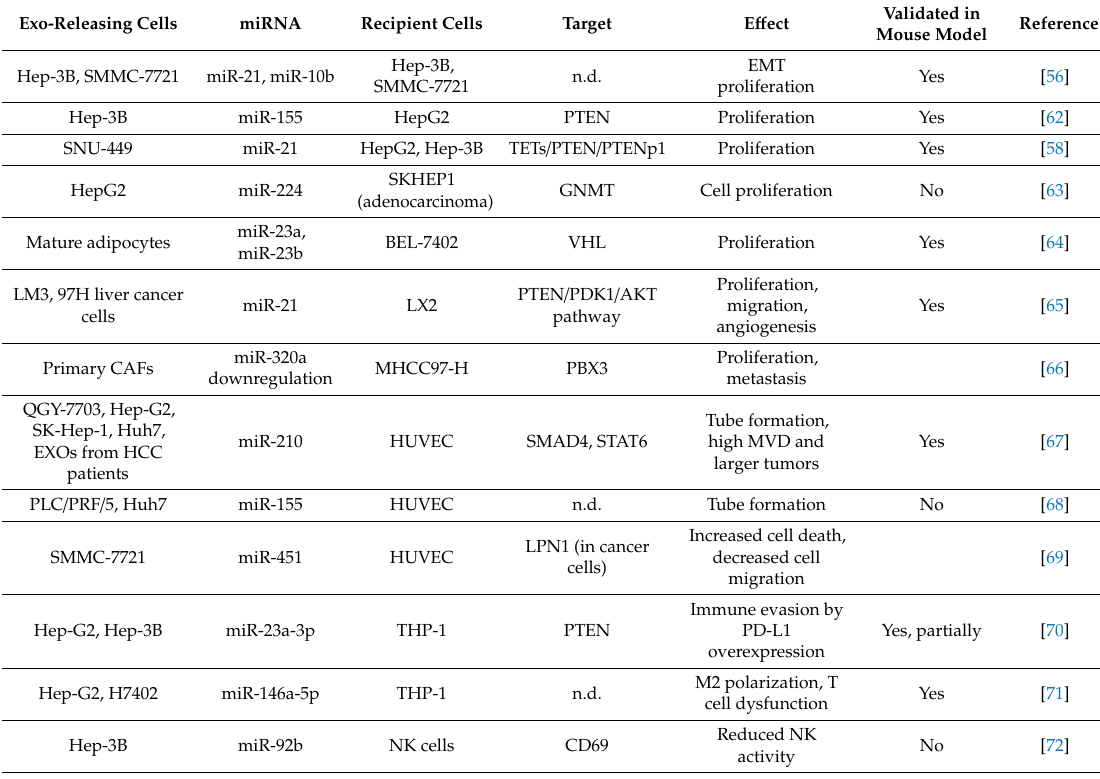
Table 1. Exosomal miRNA involved in cell-to-cell communication in hepatocellular carcinoma (HCC). Exo-Releasing Cells